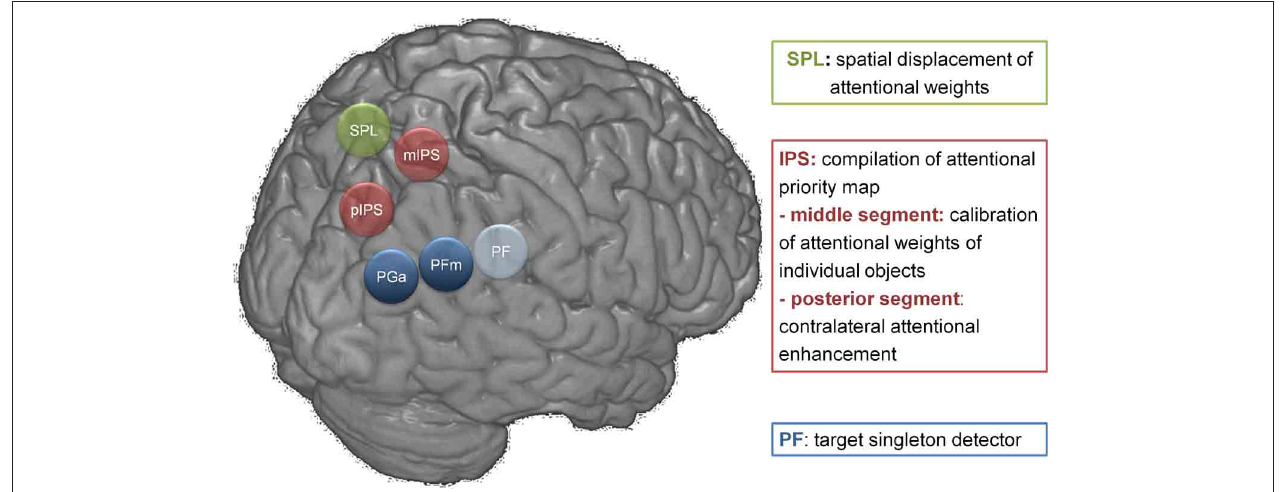
2013; Cabeza et al., 2012). The cytoarchitectonic labeling of inferior parietal cortex is based on Caspers et al. (2006). pIPS, posterior (descending) segment of IPS; mIPS, middle (horizontal) segment of IPS; SPL, superior parietal